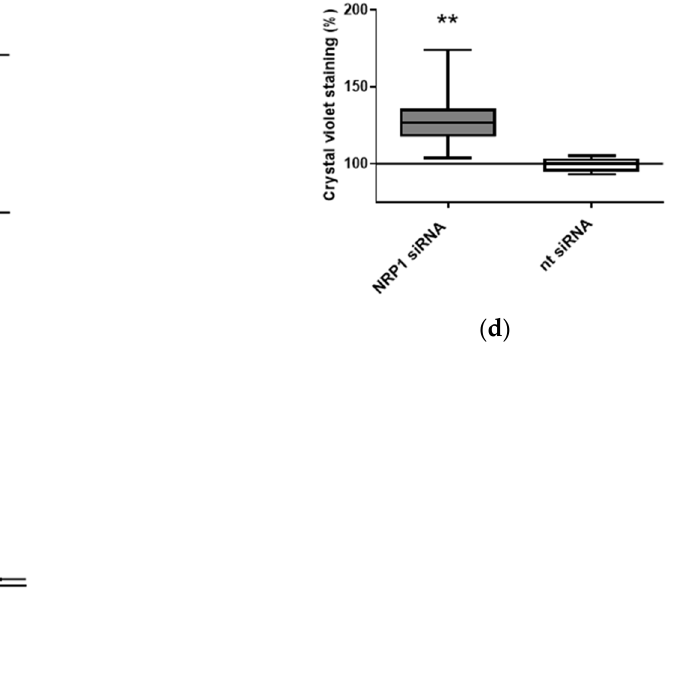
Figure 3. NRP1 knockdown in OA chondrocytes. ( a ) Relative NRP1 gene expression in OA chon- drocytes after transfection with NRP1 siRNA or nt (non-target) siRNA. One sample t-test; n = 8, *** p ≤ 0.001; ( b ) Representative Western blot pictures for Nrp1 and β-actin protein expression after transfection with NRP1 siRNA or nt siRNA in chondrocytes of three different donors are shown. ( c ) Proliferation was determined after transfection with NRP1 siRNA or nt siRNA. One sample t-test; n= 7, * p ≤ 0.05; ( d ) Adhesion was determined after transfection with NRP1 siRNA or nt siRNA. One sample t-test; n = 7, ** p ≤ 0.01; ( e ) Senescence was determined after transfection with NRP1 siRNA or nt siRNA. One sample t-test; n = 4, * p ≤ 0.05.